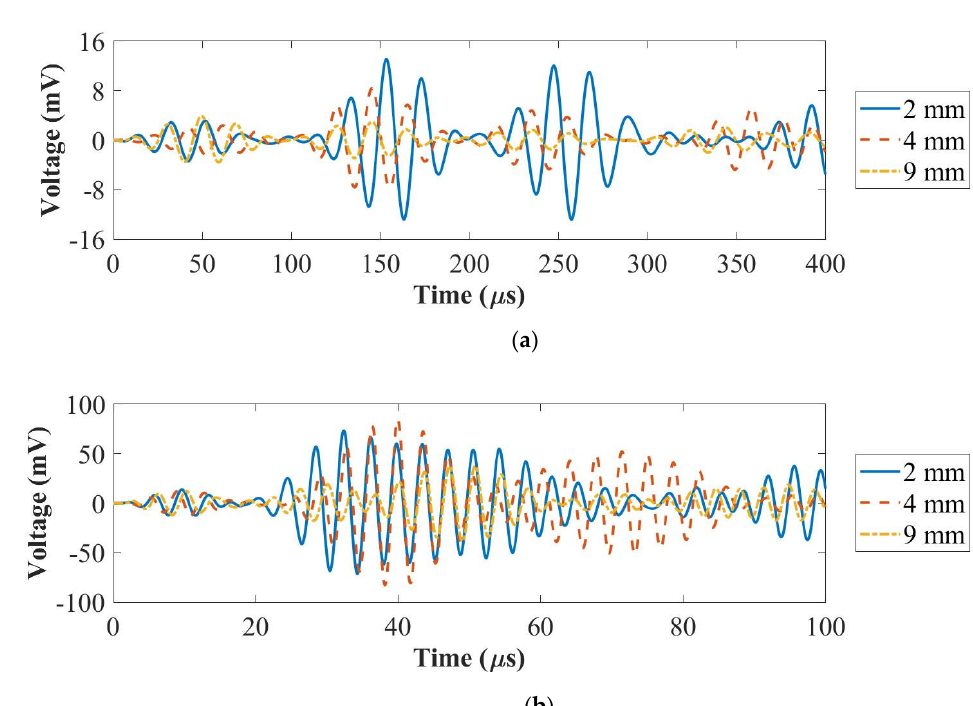
Figure 5. UGW comparisons for the panels with the thicknesses of 2 mm, 4 mm and 9 mm at 50 kHz ( a ) and 250 kHz ( b ).